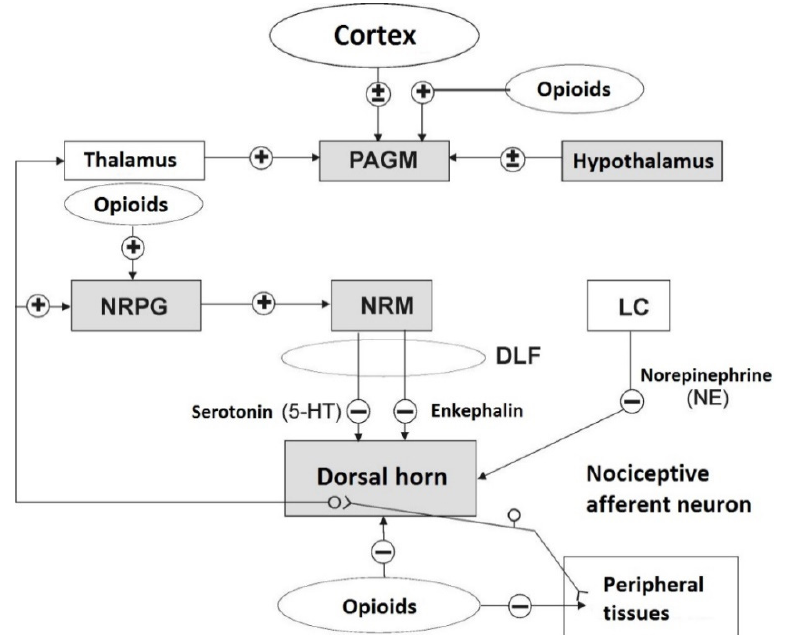
Figure 3. Diagram of the descending control system with the main sites of opioid action on pain transmission. Opioids stimulate neurons in the periaqueductal gray matter (PAGM) and in the nucleus reticularis paragigantocellularis (NRPG), which in turn projects into the antero-ventral region of the medulla oblongata, where the nucleus raphe magnus (NRM) is located. From NRM, neurons containing 5-hydroxytryptamine (5-HT) and enkephalinergic (ENK) neurons head to substantia gelatinosa of the spinal dorsal horn, where they inhibit the transmission of nociceptive impulses. Opioids also have a direct inhibitory effect on the spinal dorsal horn, as well as on the peripheral endings (nociceptors) of the nociceptive afferent neurons. Locus coeruleus (LC) directs noradrenergic (NE-ergic) neurons to the dorsal horn, in which they also inhibit the transfer of nociceptive stimuli. The pathways depicted in this diagram constitute a significant simplification; however, it reflects the overall organization of supraspinal control mechanisms enabling pain inhibition. Glossary: DLF—dorsolateral funiculus; + stimulation; − inhibition; shaded fields represent regions (structures) with a high concentration of opioid peptides (based on